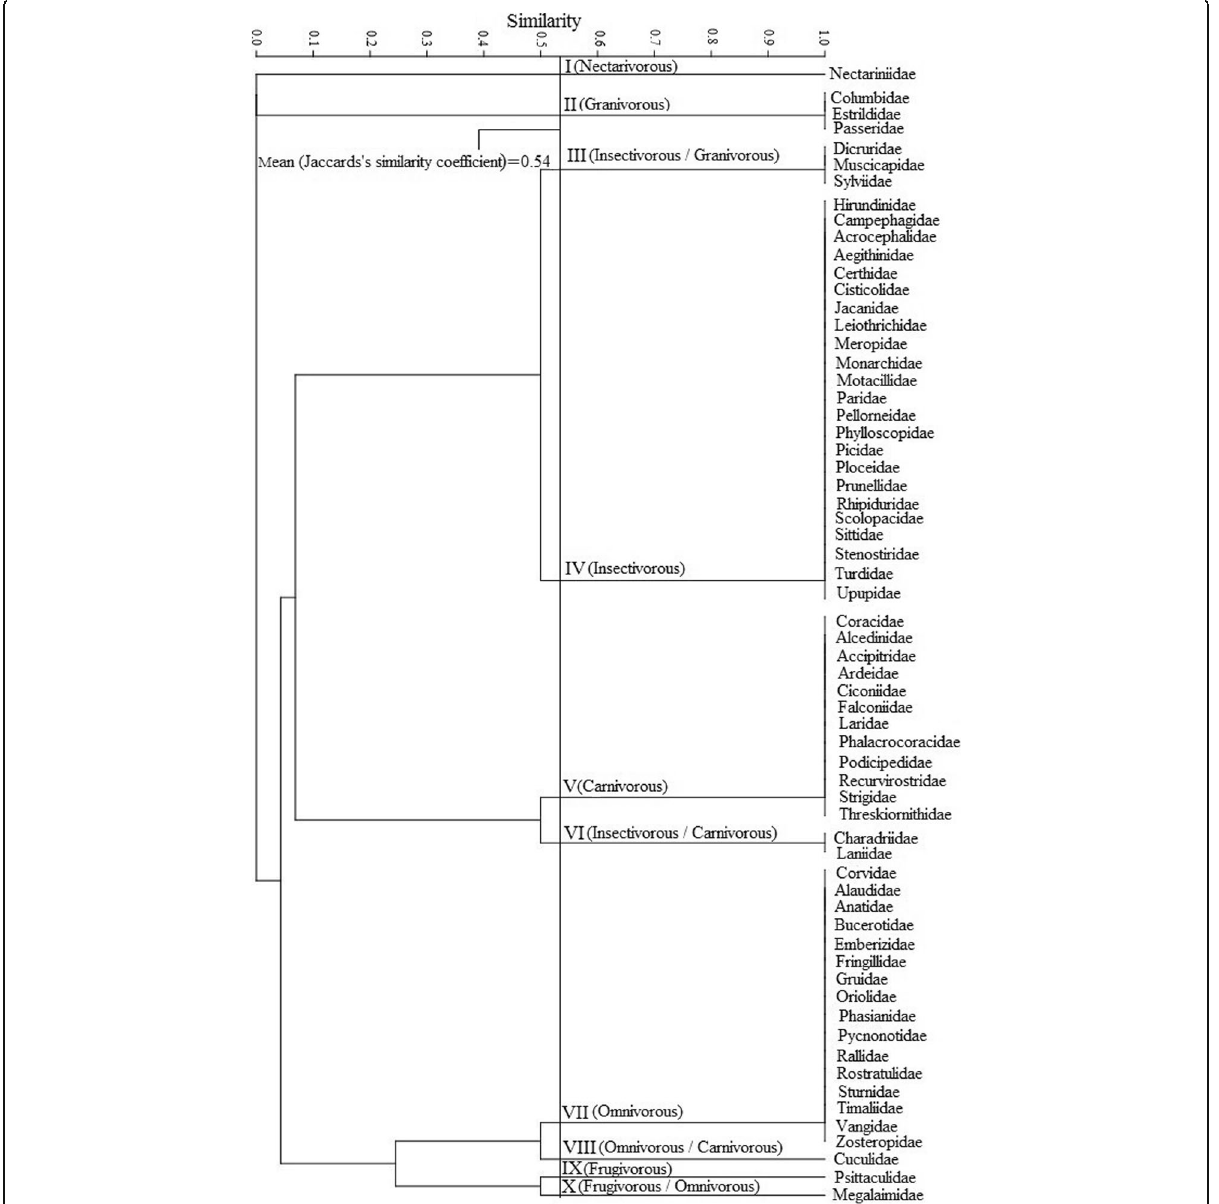
Fig. 6 Jaccard ’ s similarity dendrogram showing foraging guild structure among observed bird families in the study